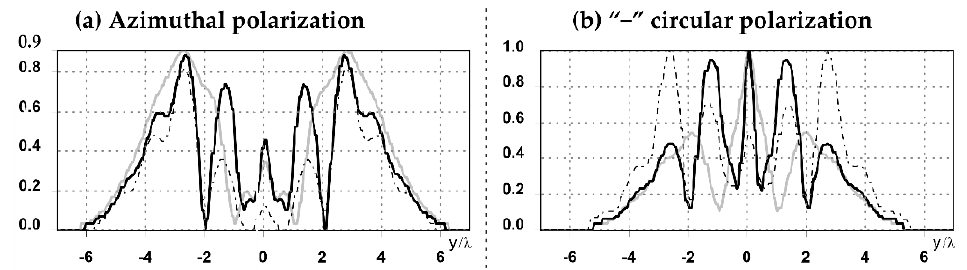
Figure 2. The cross sections for the cases in Table 2, circular protrusion with r = 2.0 λ (black line), circular protrusion with r = 1.0 λ (gray line), circular deepening (dash–dotted line): ( a ) azimuthal polarization, ( b ) “ − ” circular polarization.